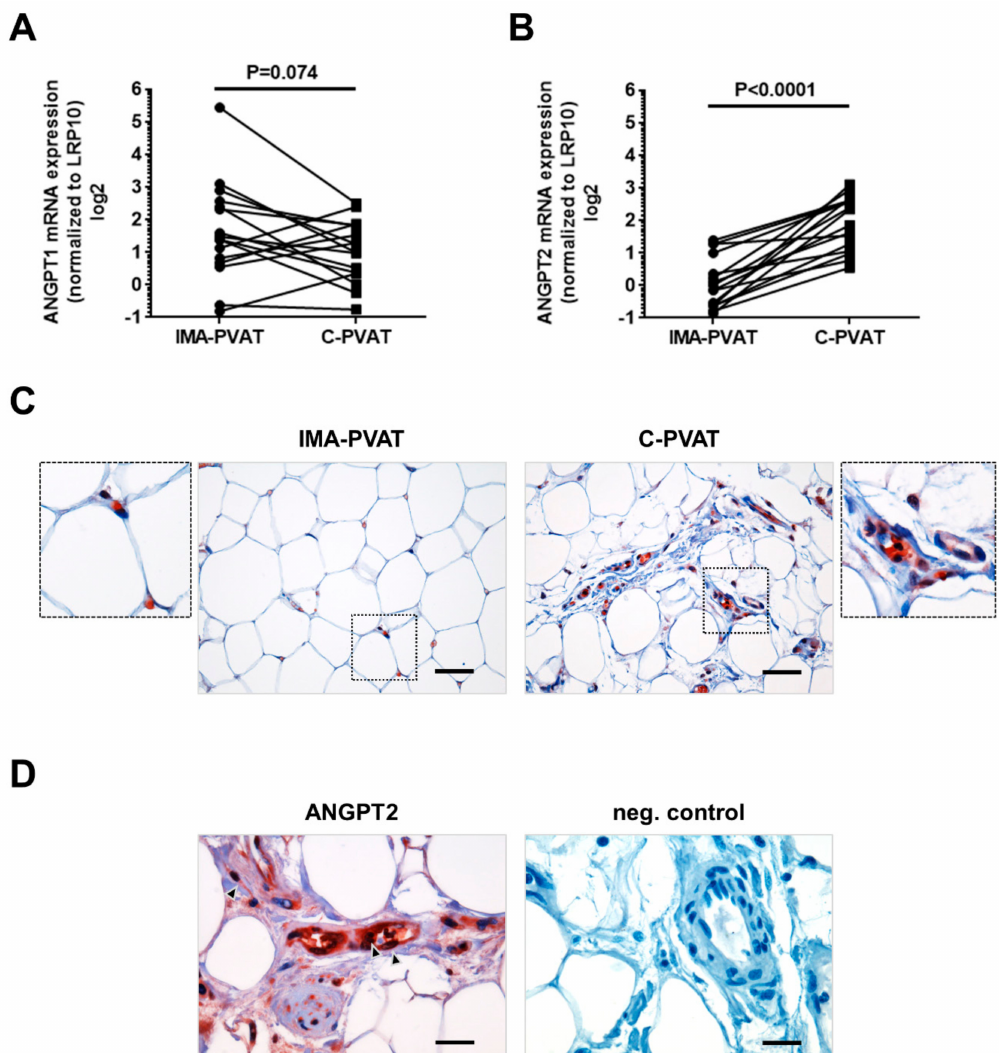
Boxes of the same color on both membranes mark the respective dot pairs for each protein. Positive and negative control dots are also marked. ( B ) Heat map representation of the expression of 29 proteins quantified using membrane-based protein array analysis in IMA-PVAT- and C-PVAT-derived conditioned medium of n = 5 patients with CAD. Each column represents one patient (P1, P2, etc.). ( C ) Quantitative analysis shown for proteins exhibiting a statistically significant di ff erence in expression between IMA-PVAT and C-PVAT. Bars represent fold change of mean protein expression compared to IMA-PVAT. Error bars represent standard deviation. Statistical analysis was performed using Student’s paired t -test.